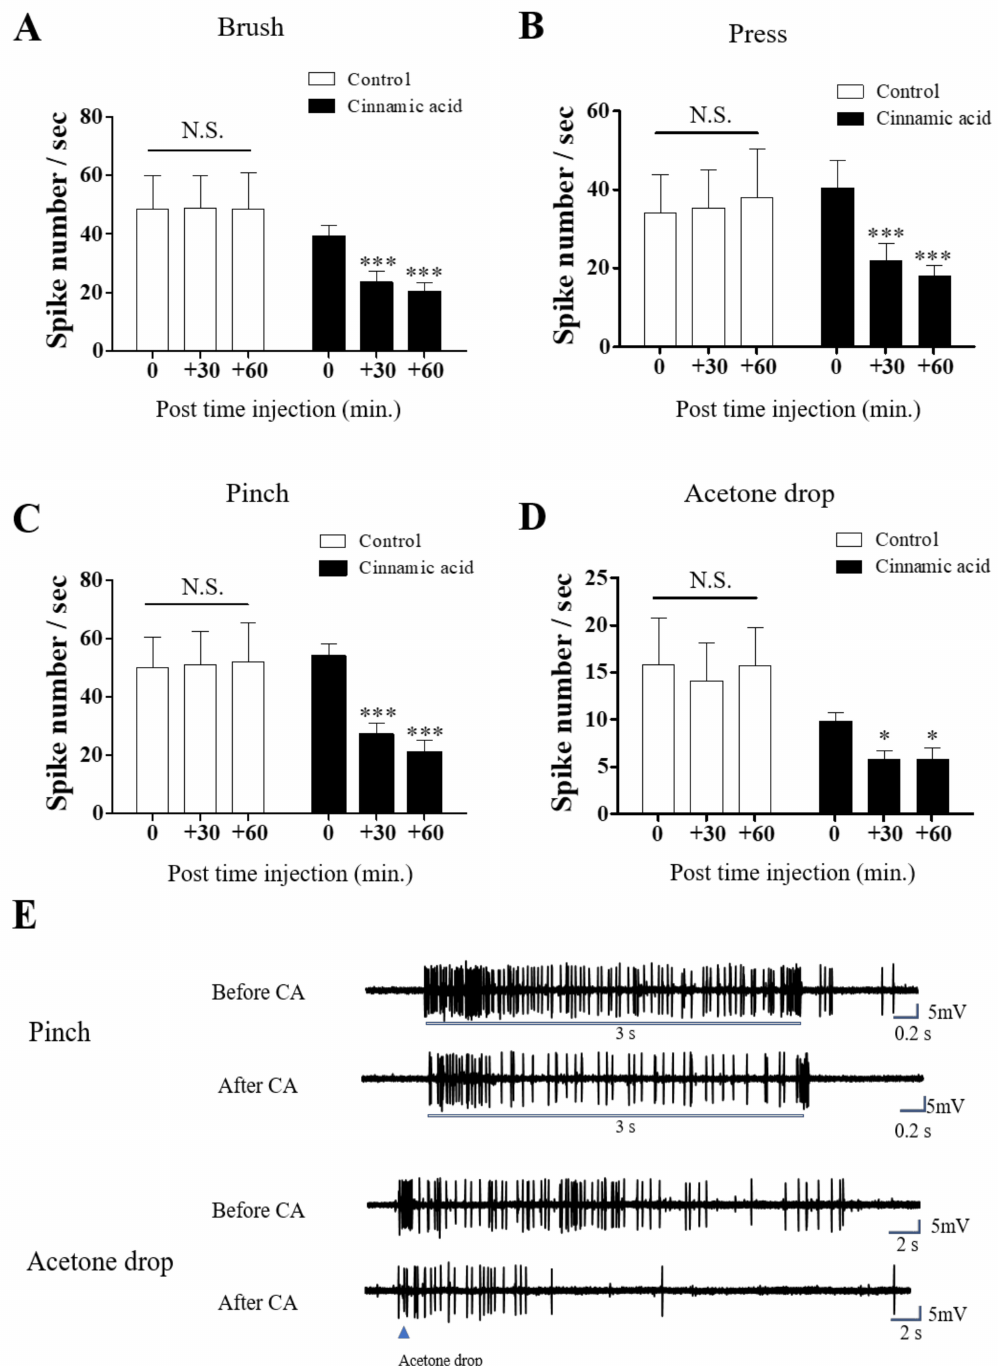
Figure 4. CA inhibits the hyperexcitability of spinal dorsal horn WDR cells to cutaneous stimuli in oxaliplatin treated rats. In vivo extracellular recordings were used to measure the change in firing frequencies of WDR cells to cold and mechanical stimuli after CA administration (20 mg/kg, i.p.) in oxaliplatin injected rats; n = 8. Control rats received the same volume of 10% DMSO; n = 6. Data is presented as the mean ± S.E.M.; * p < 0.05, *** p < 0.001 vs. time point zero; by Dunnett’s multiple comparisons test after two-way ANOVA ( A–D ), N.S.; non-significant. ( E ) Representative raw trace of WDR neuron firings in response to pinch or acetone drop stimuli before and after injection of